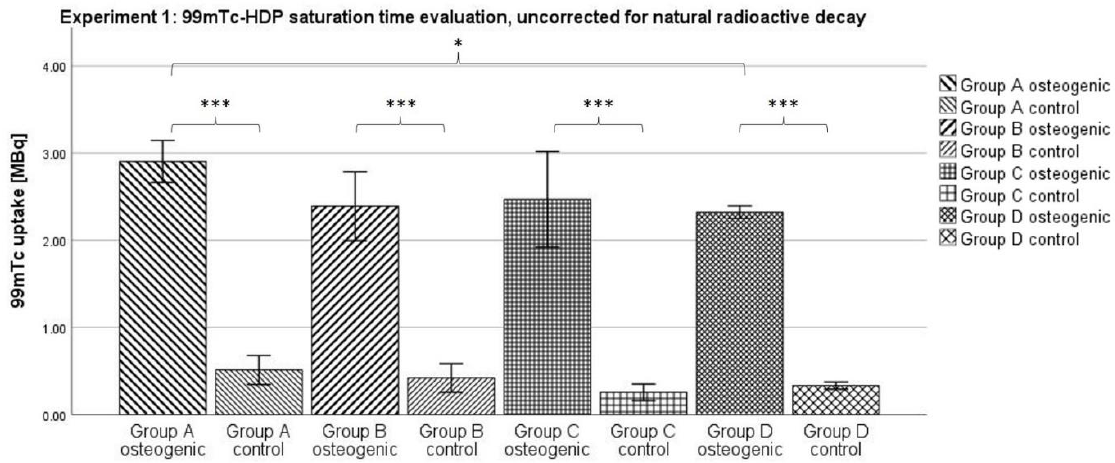
Figure 2. Mean 99m Tc-HDP uptake as measured by the dose calibrator when testing for the saturation time and not correcting for natural radioactive decay. The error bars show the standard deviation. Stars indicate significant differences between the two groups connected by a bracket. * = significance p ≤ 0.05; *** = significance p ≤ 0.001. n =